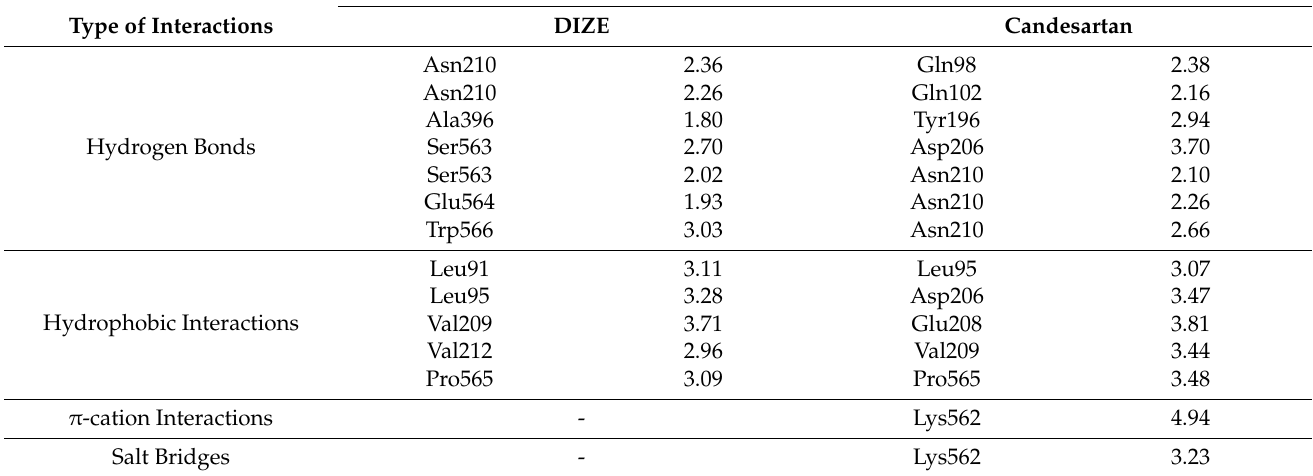
Table 3. Interactions of the amino acid residues of the spike protein receptor-binding domain/ACE2 complex of SARS-CoV-2 (PDB ID: 6LZG) with DIZE and candesartan using PLIP. Amino Acids of Spike Protein RBD Involved and Distance of Interactions